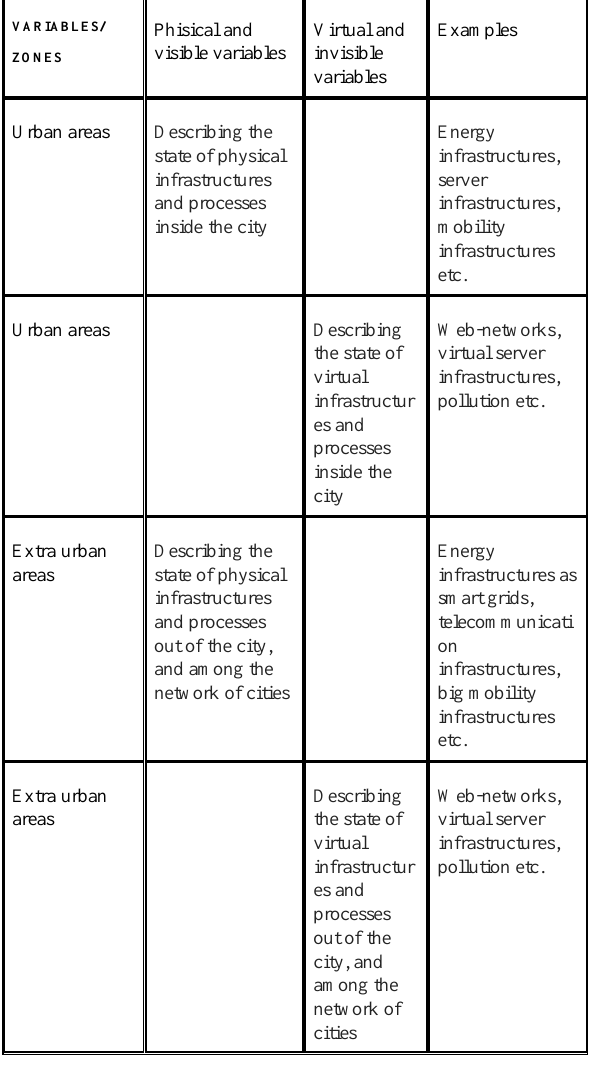
Table 1; Topics of smart communication for smart cities The techniques of a smart communication are similar for visible or invisible variables, and are based on the representation of urban and extra-urban infrastructures and processes on thematic maps.